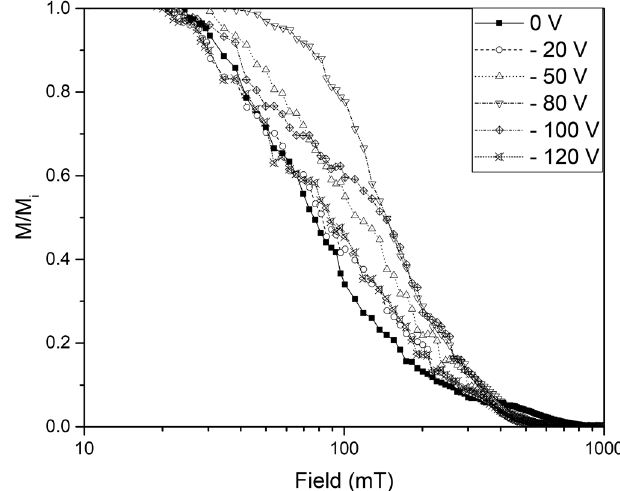
V.FIG. 4. The magnetic field H C 2 for each deposited